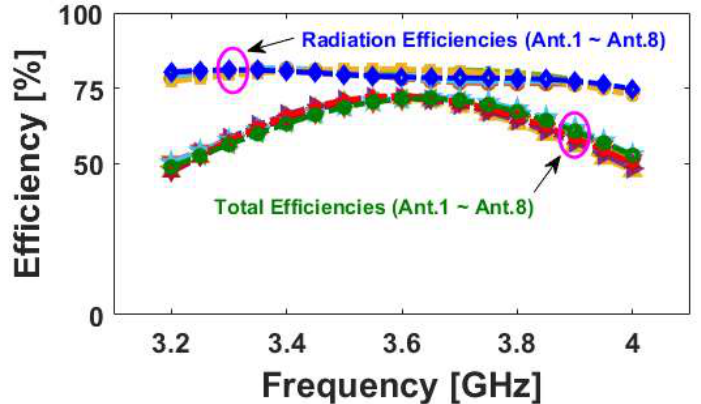
Figure 12. 3D radiation patterns of the fifth generation (5G) mobile-phone antenna.